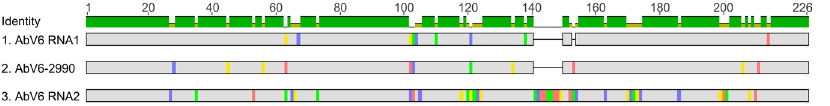
Figure 3. Alignment of the final 226 bases of the 3 ′ UTR of AbV6 RNA1, AbV6-2990 (a strain of AbV6 found in sample 2990) and AbV6 RNA2. The grey regions indicate bases that match the consensus sequence (defined as sequence shared by two out of 3 of the RNAs) whilst the coloured highlights indicate disagreements. Scale is length in